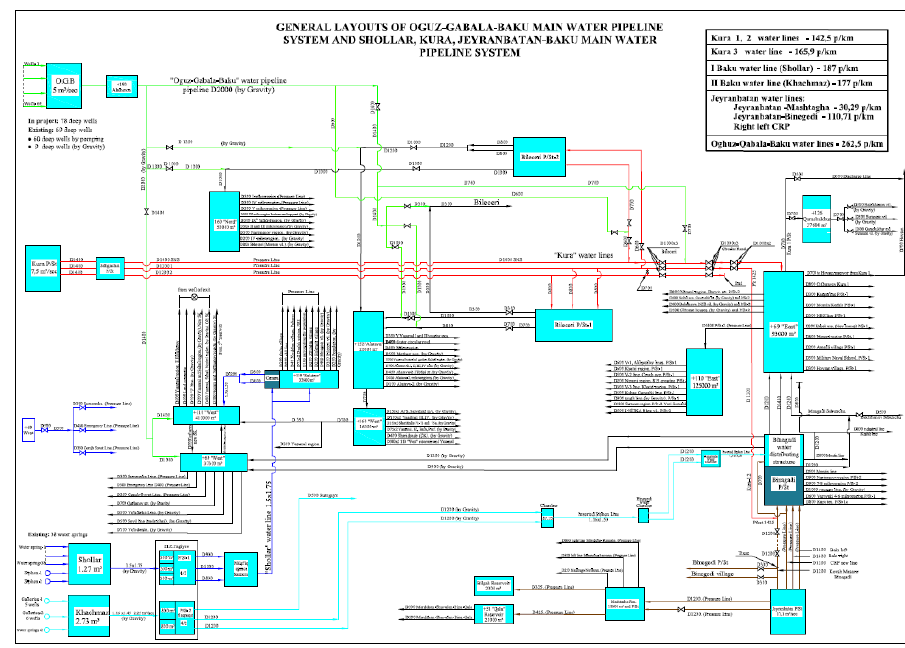
Figure 1. The main water lines in Azerbaijan